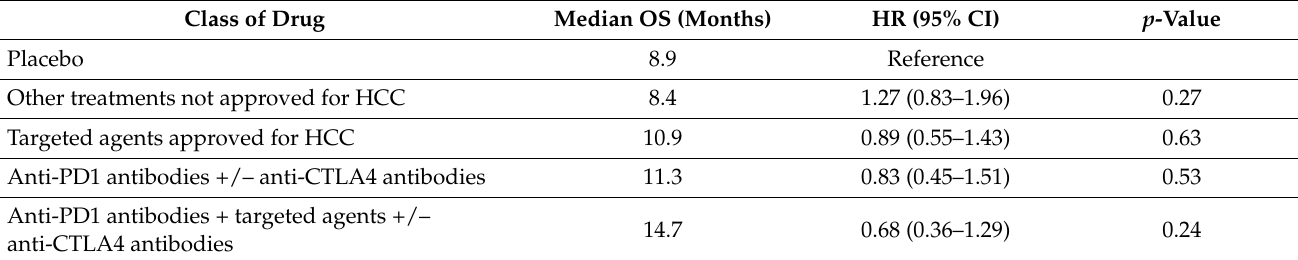
Figure 1. Overall survival by second-line treatment: approved treatments (AT) versus other treat- ments (OT). Table 2. Overall survival according to second-line treatment received.